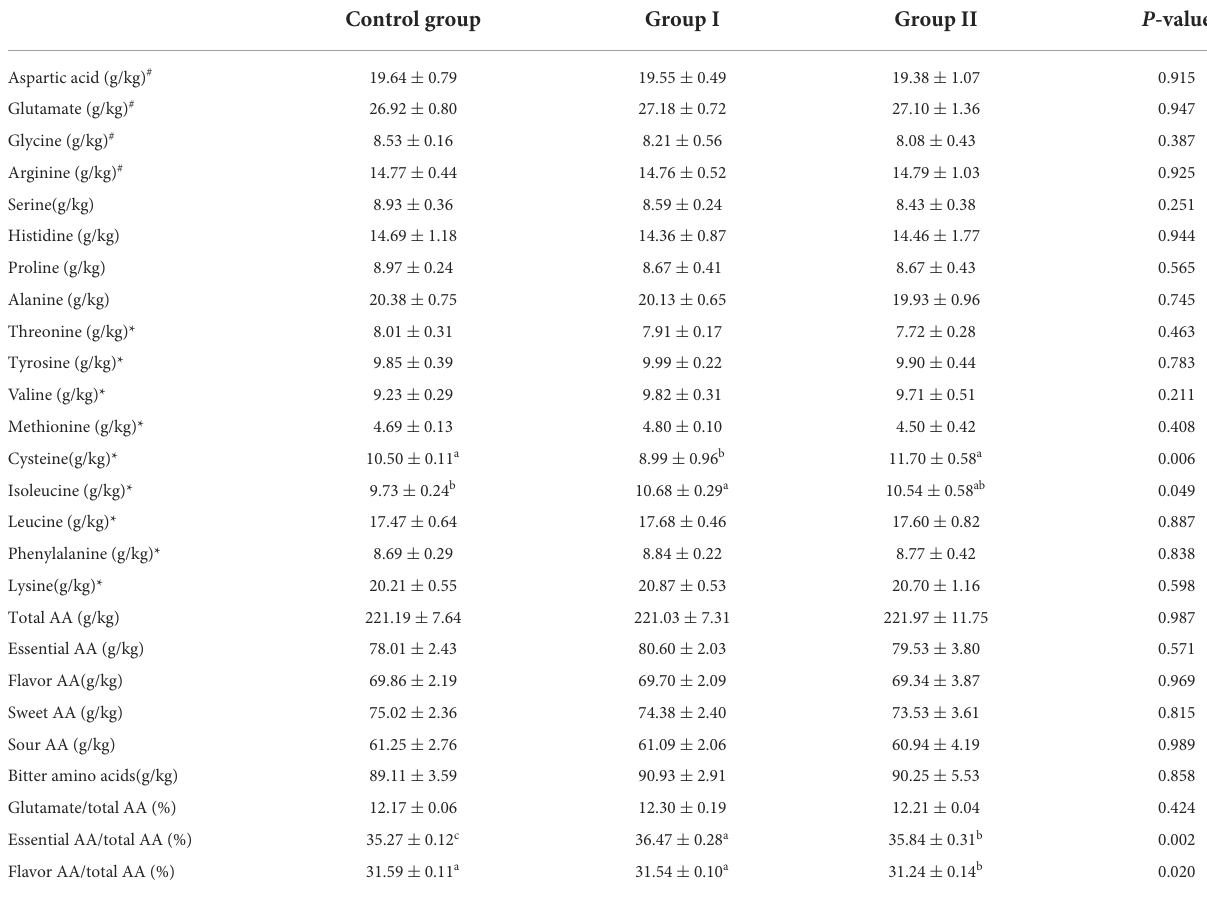
TABLE 7 Effects of dietary protein level on amino acids in muscle of finishing pigs (fresh meat).